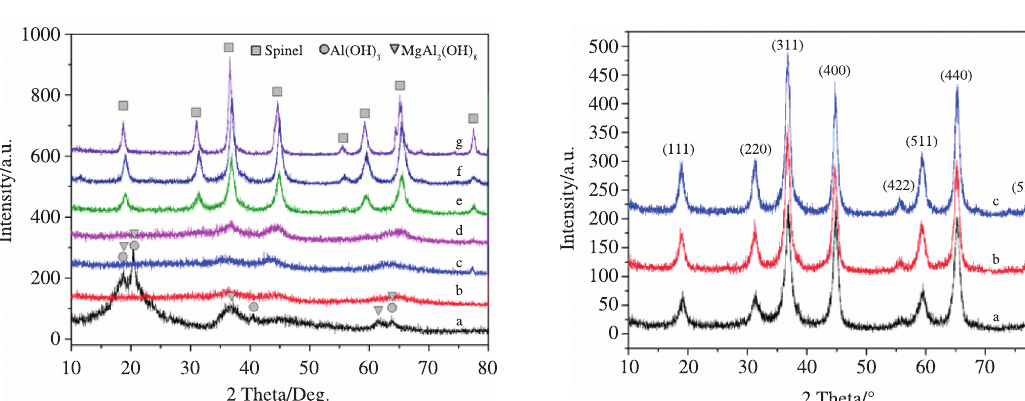
O samples calcined 2 4